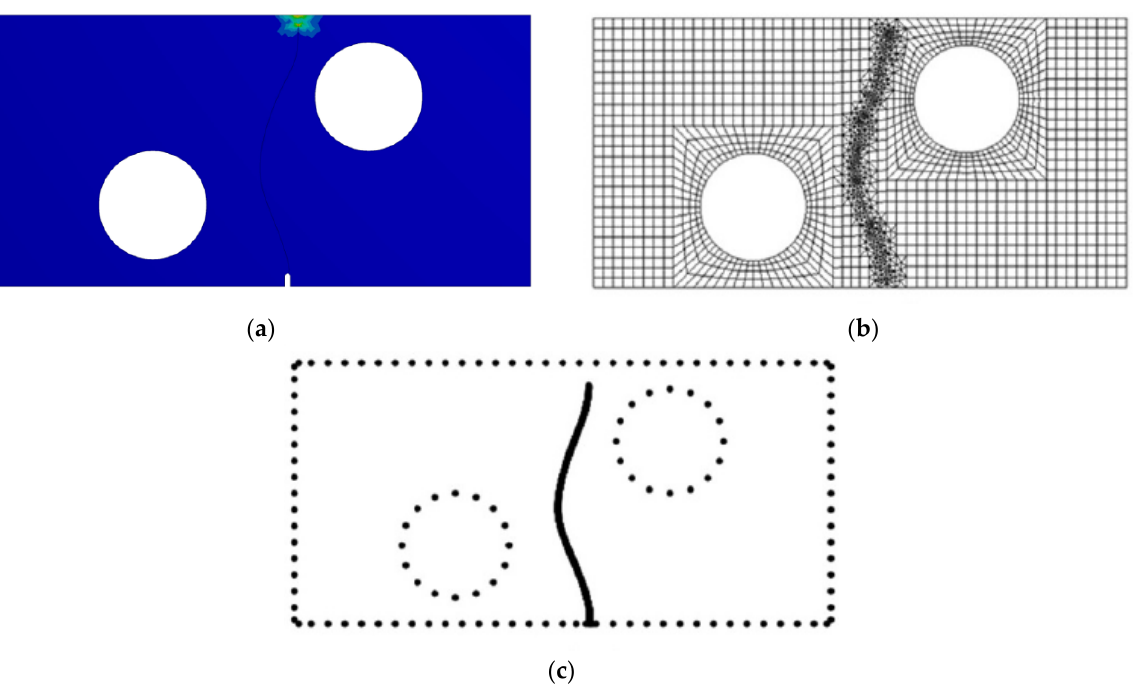
Figure 7. Crack growth path ( a ) present study, ( b ) dual boundary element method [44], and ( c ) FEM with Franc2d/L [45].